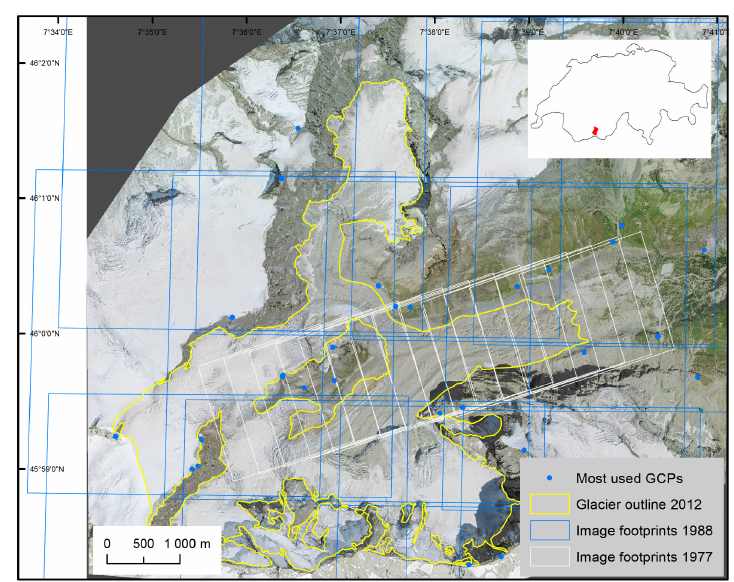
Figure 1. The study site, showing a subset of base GCPs used for most DTMs, as well as the rough footprint of the aerial images from 14 September 1977 and 07 September 1988, which are also representative for the other glacier and mapping campaigns, respectively.